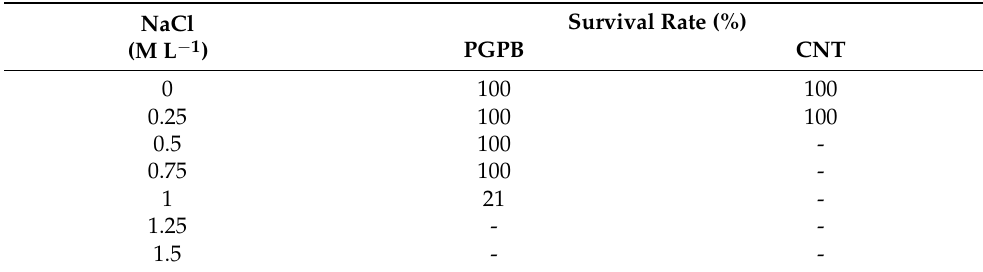
Table 3. Survival rate (%) recorded during the greenhouse experiment on T. durum for inoculated plant growth-promoting bacteria (PGPB) and uninoculated plants (CNT).